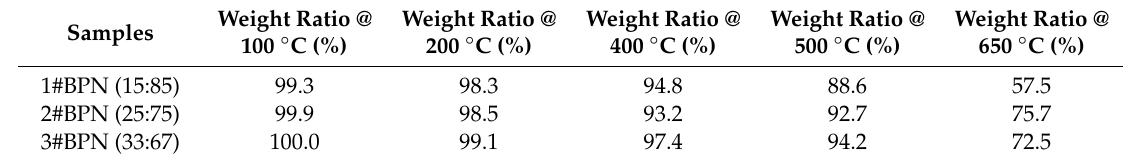
Table 3. Weight statistics of potassium boron nitrate samples at di ff erent temperatures.